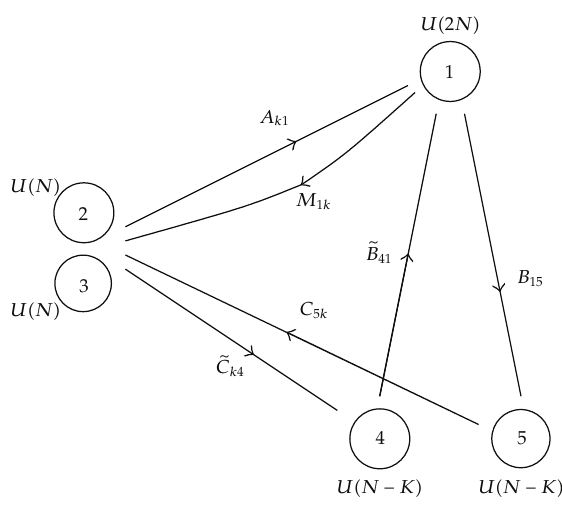
Figure 5: Quiver gauge theory for the cone over dP 6 after Seiberg duality on node